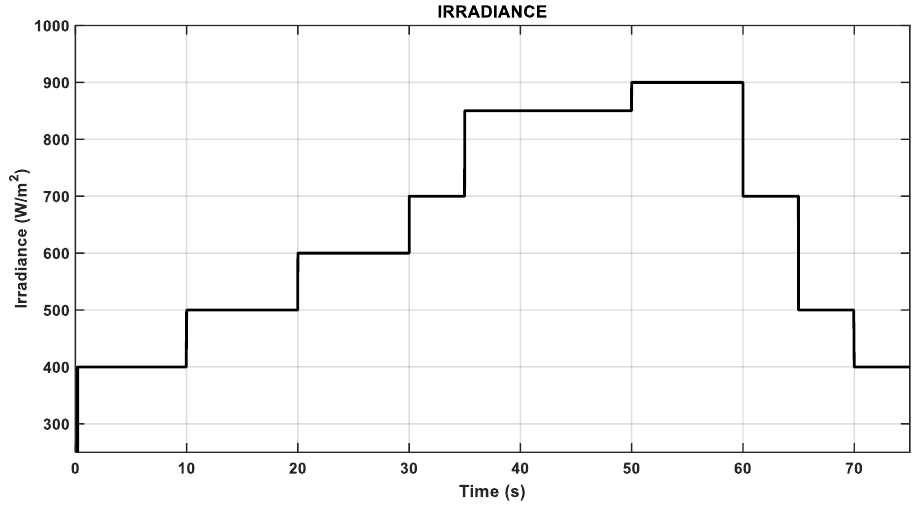
Figure 10. Irradiance profile.